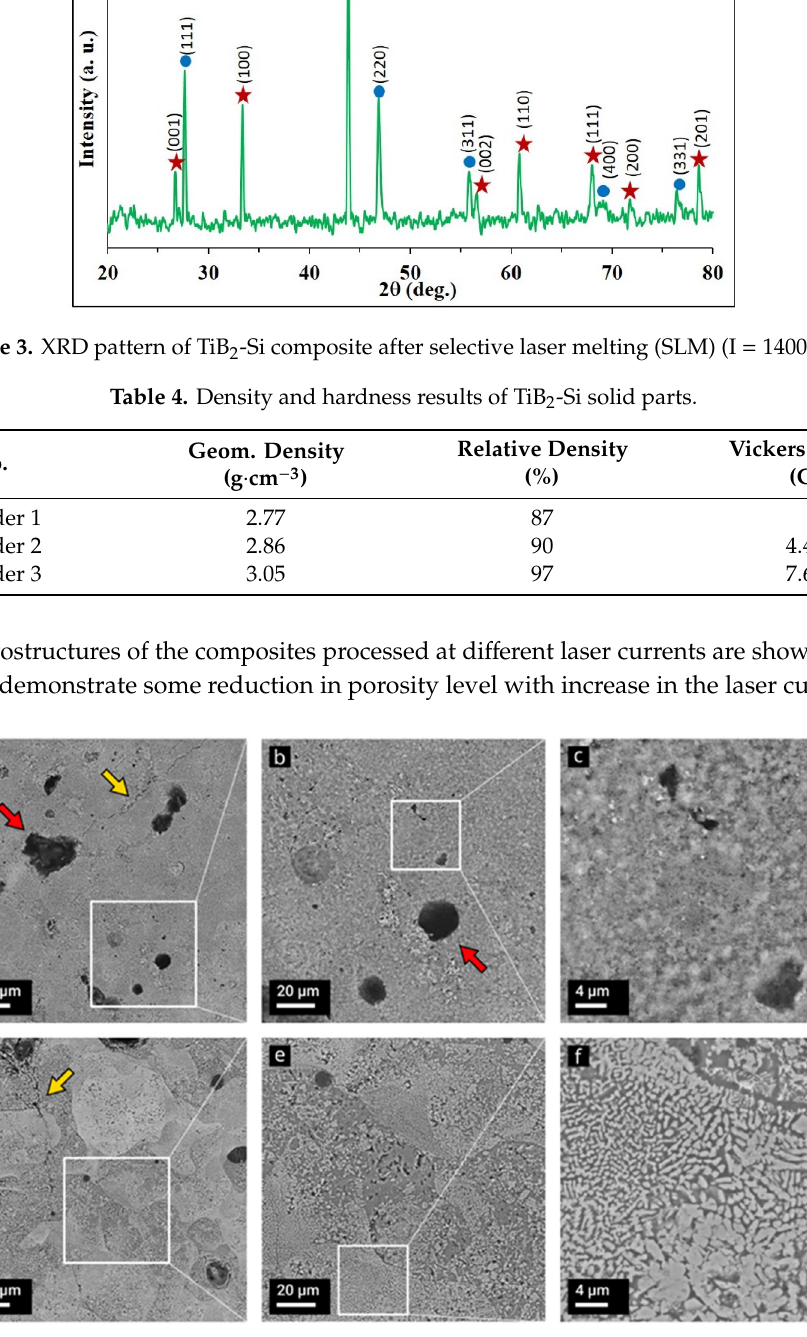
Figure 4. Top surface backscattered electron (BSE) images of TiB 2 -Si bulks printed by SLM at 1400 mA ( a – c , Cylinder 1) and 1800 mA laser current ( d – f , Cylinder 2). Cracks and pores are pointed out by yellow and red arrows, respectively.